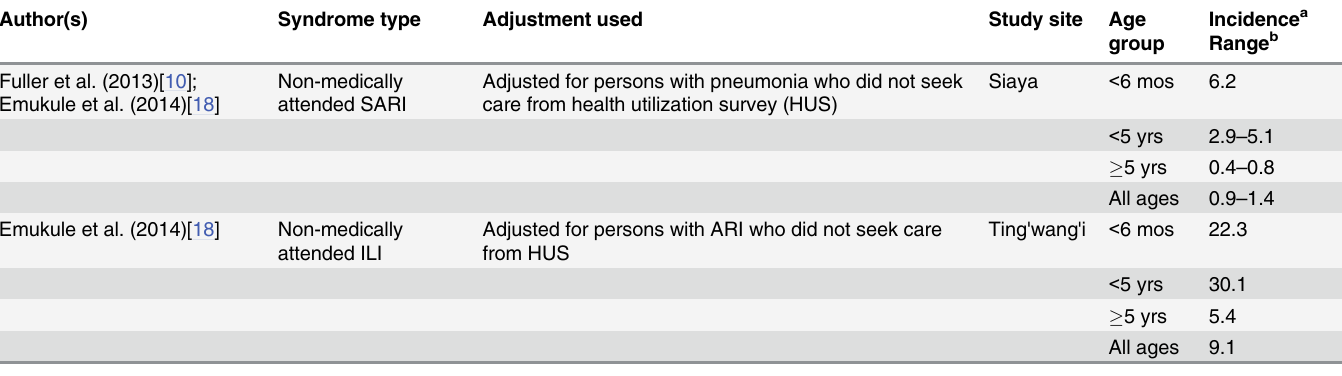
Table 3. Non-medically attended average annual incidence rates of Influenza reported for different respiratory syndromes (per 1,000 persons or person-years) in